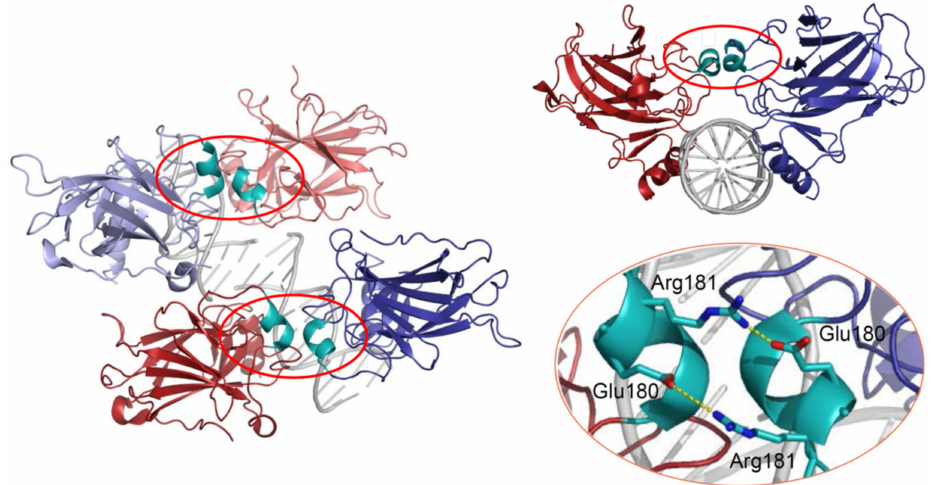
Figure 2. 3D structure of the p53 DBD tetramer in complex with DNA (based on RCSB Protein Data Bank ID:2AHI). H1 helices are highlighted in cyan; ionic bonds between negatively charged Glu180 and positively charged Arg181 are shown in